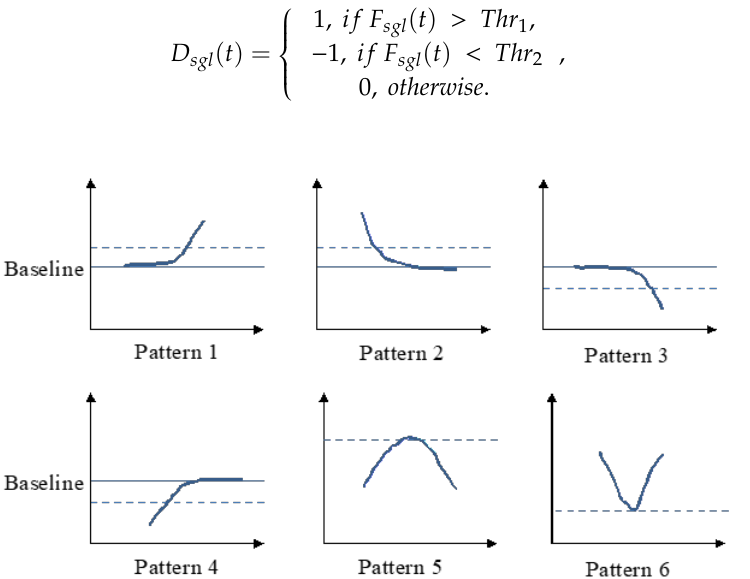
Figure 4. Six patterns which are found as the features of the onset or offset points in Figure